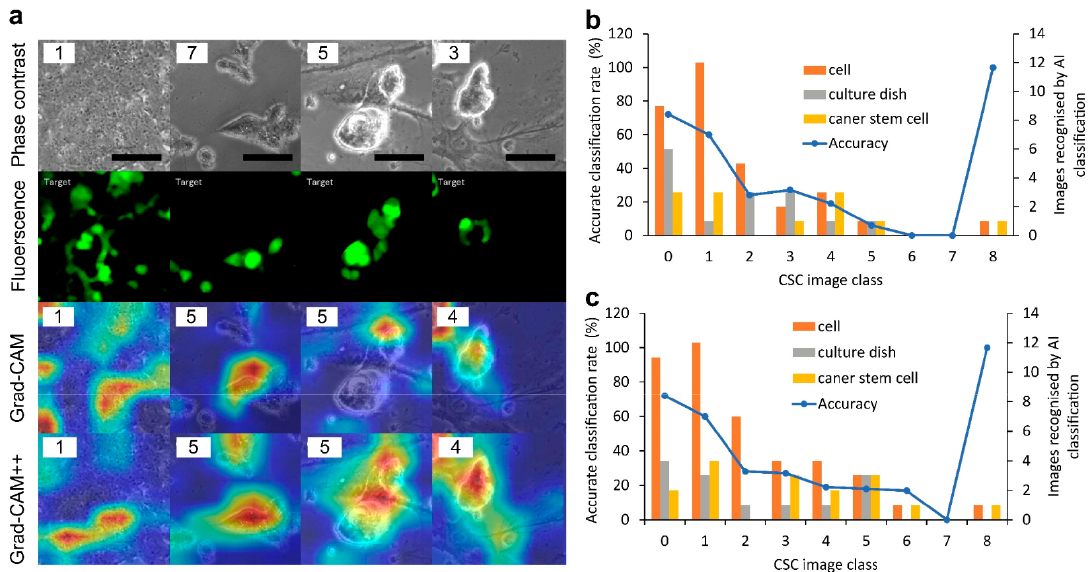
Figure 3. Visualization of convolutional neural network (CNN) classification. ( a ) Output example of an image. Input images of phase contrast belong to the class as labeled on the top left of each image. For example, class 7 is labeled as 7. Fluorescence images paired with phase contrast show the CSC region. The output class by CNN classification using gradient-weighted class activation mapping (Grad-CAM) and Grad-CAM++ is labeled on the top left of each image. The region of the heat map color indicates the position where the CNN shows the referring objects during deep learning. A darker shade of red indicates that the probability of the position is higher. Scale bars = 100 µ m; ( b ) Objects recognized by CNN classification using Grad-CAM. Objects of cells, culture dishes, and CSCs, which are marked with red, were counted for each image; ( c ) Objects recognized by CNN classification using